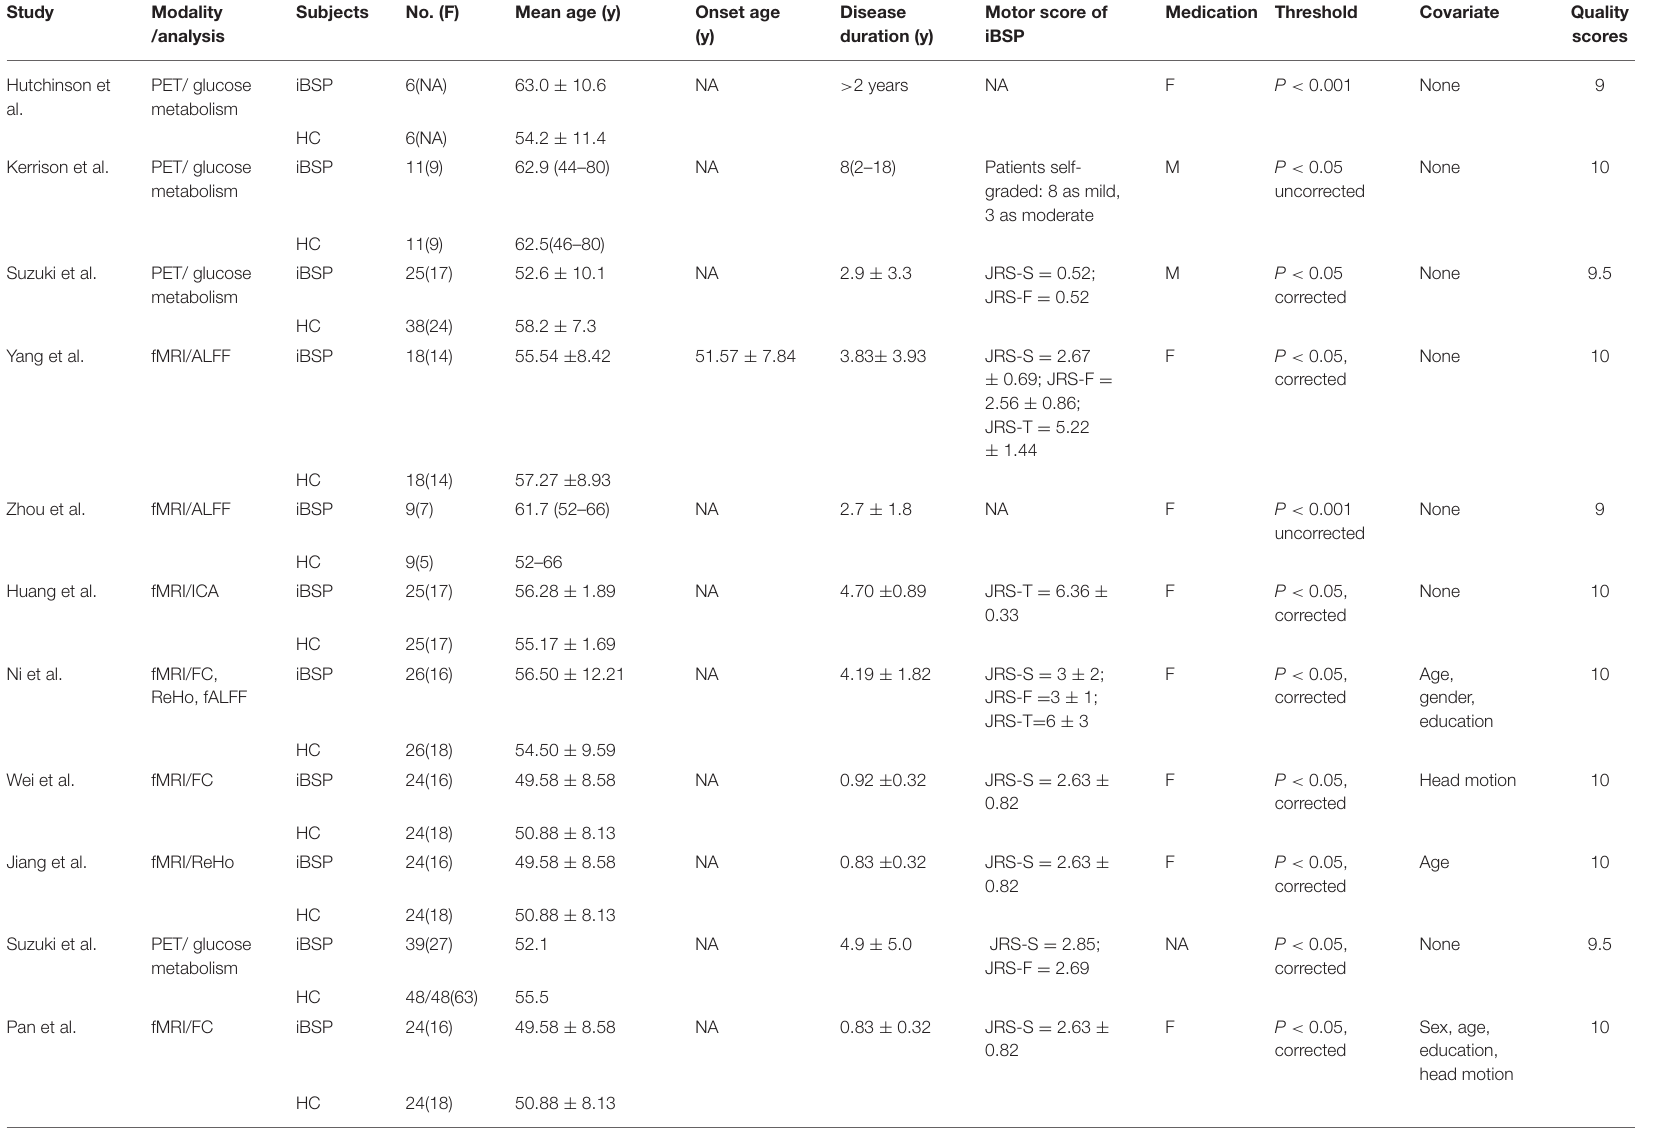
TABLE 2 | Characteristics of included functional studies in the